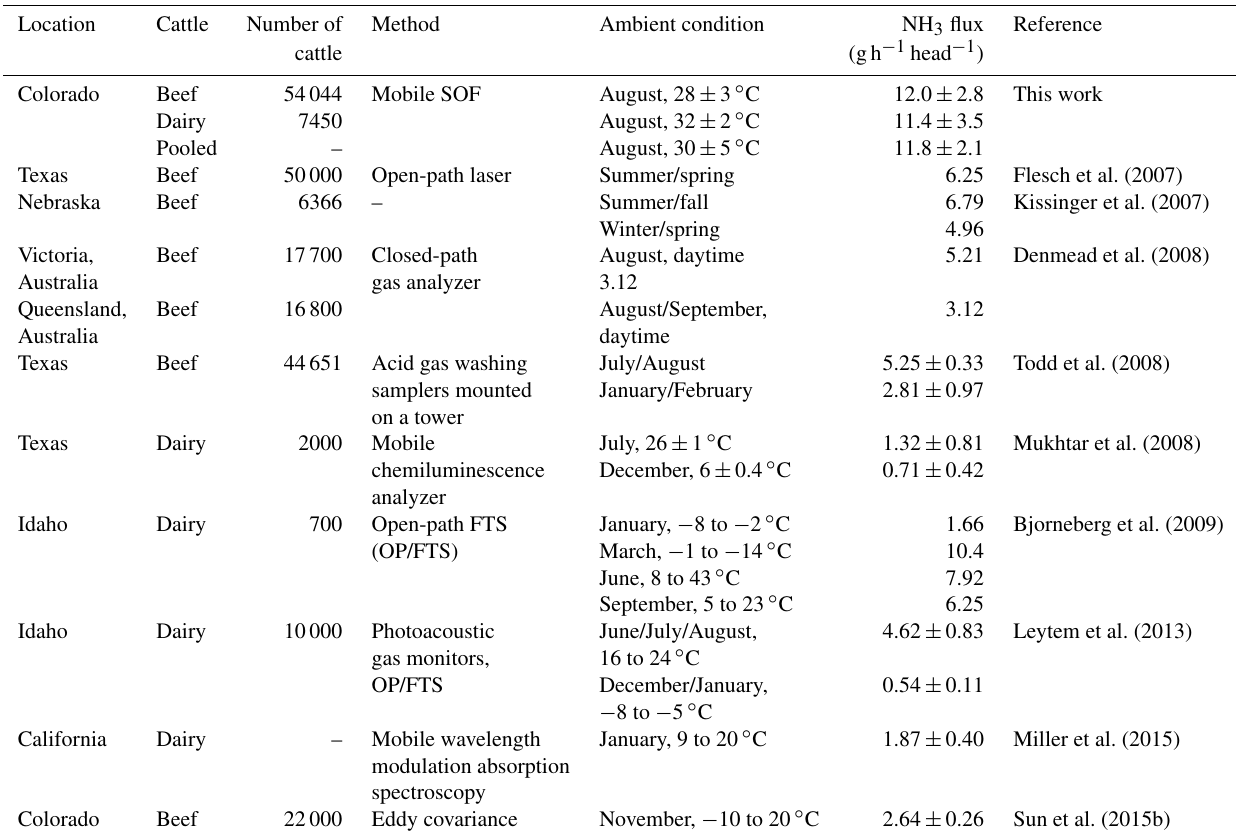
Table 6. Comparison of NH 3 emission rates from cattle with literature values.